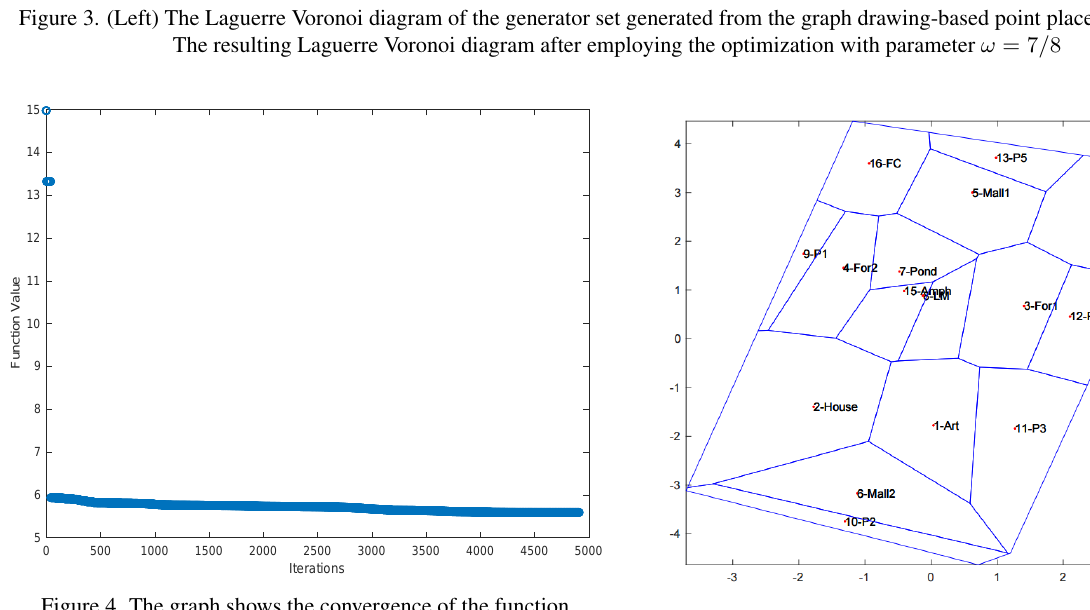
Figure 5. Laguerre Voronoi diagram obtained point positions in the master plan of CMU square Dong, P.,